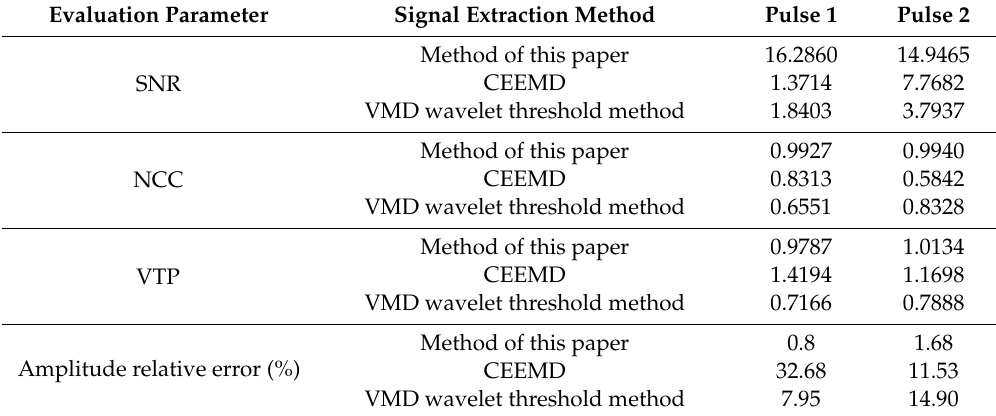
Table 1. Denoising effect evaluation parameters of each method.